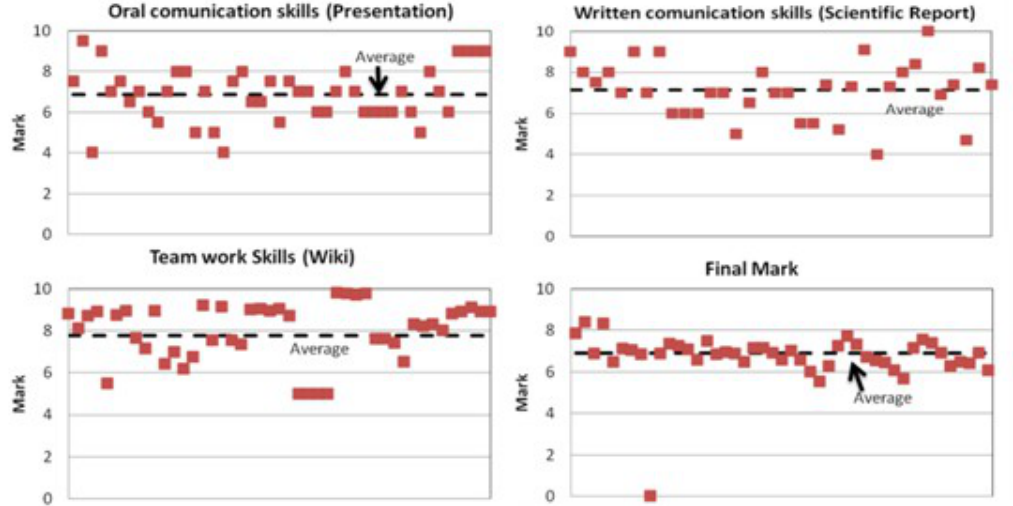
Figure 3. Students' marks in the assessment of oral and writen communicaton and teamwork skills, as well as the fnal